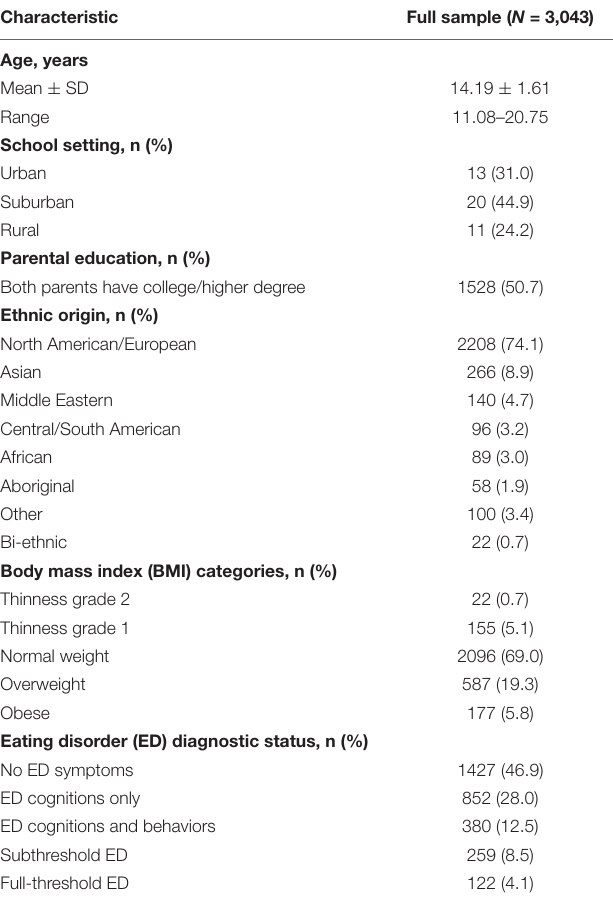
TABLE 2 | Demographic and clinical characteristics of